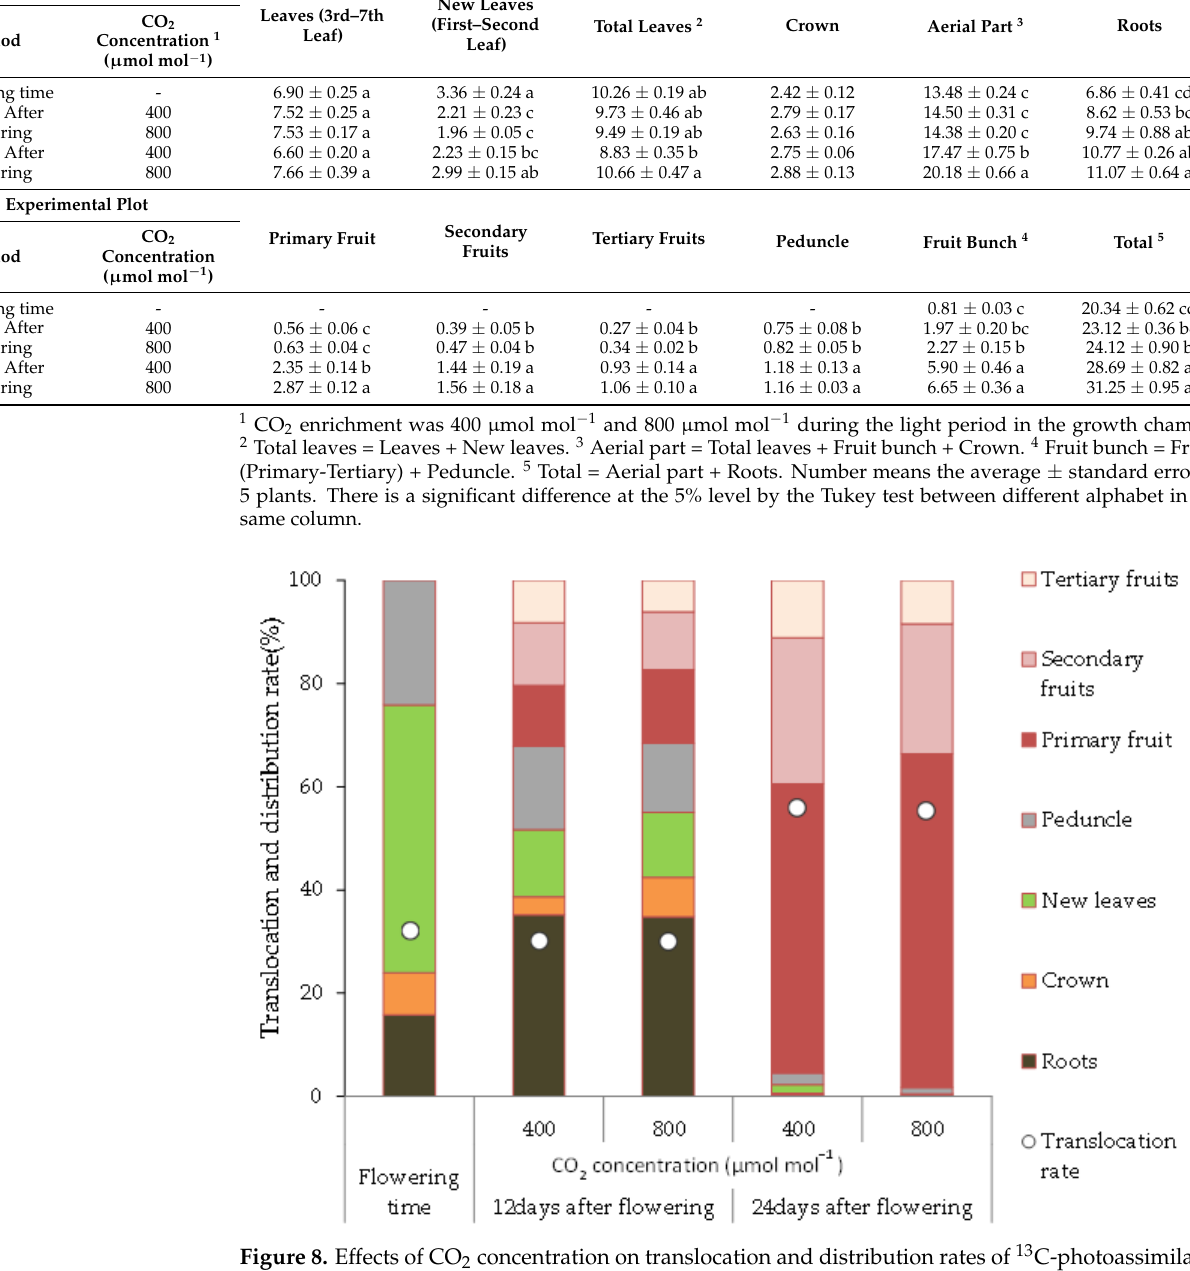
Figure 8. Effects of CO 2 concentration on translocation and distribution rates of 13 C-photoassimilates. CO 2 enrichment were 400 µ mol mol − 1 and 800 µ mol mol − 1 during the light period in the growth chamber. Table 3. Effects of different concentration of CO 2 enrichment on dry matter weight of each part of strawberry ‘Sagahonoka’.